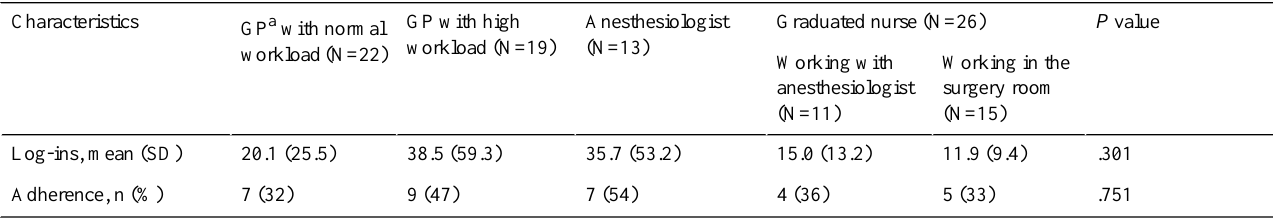
Table 2. Adherence to web-based application according to workplace.